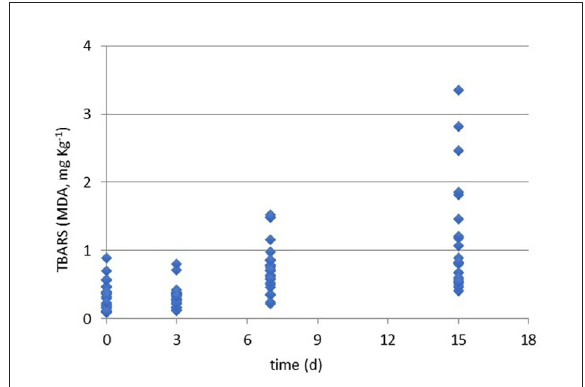
FIGURE2 Results of TBARS values (MDA, mg kg − 1 ) during the refrigerated storage time (0, 3, 7, and 15 days at 4 ◦ C) of all packaged samples.